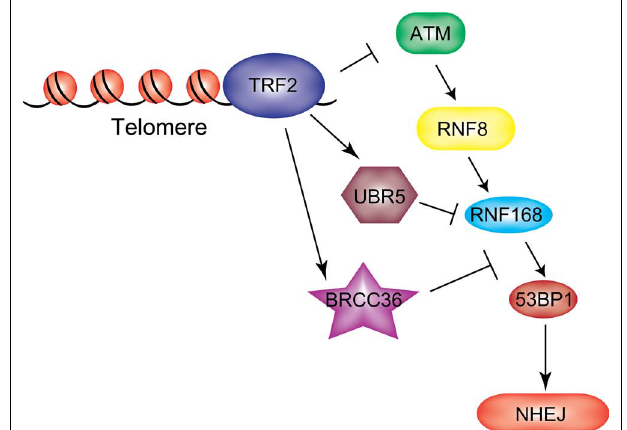
FIGURE 5 | RNF168 inhibition at chromosome ends. TRF2 protects telomeres from unwanted activation of a DDR both by preventing upstream ATM activation and by inhibiting RNF168 ubiquitylation at these sites through recruitment of UBR5 and BRCC36.